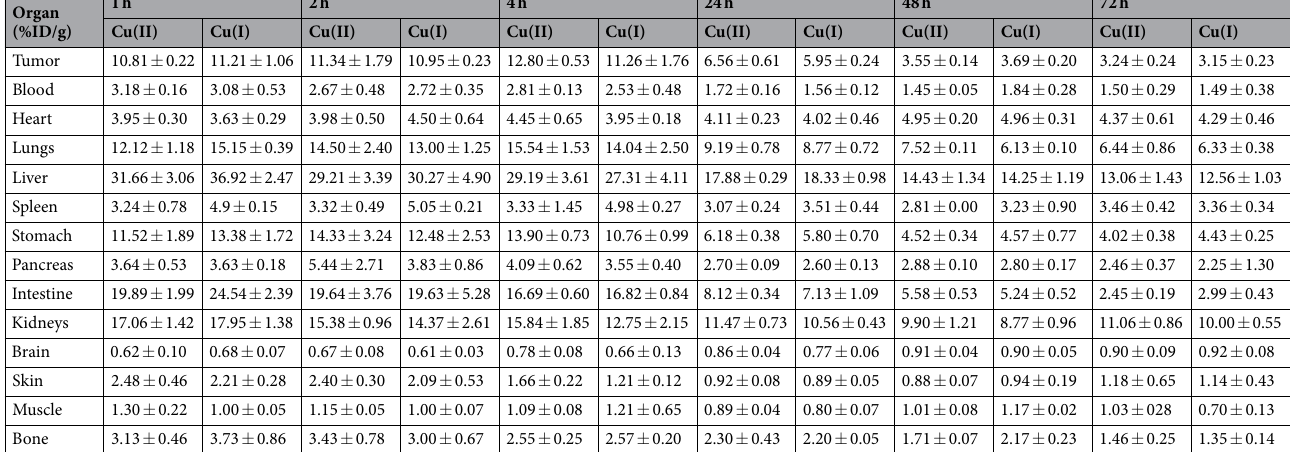
Table 1. Biodistribution Results of 64 Cu(II) and 64 Cu(I) in B16F10 Tumor-Bearing Mice (n = 4).